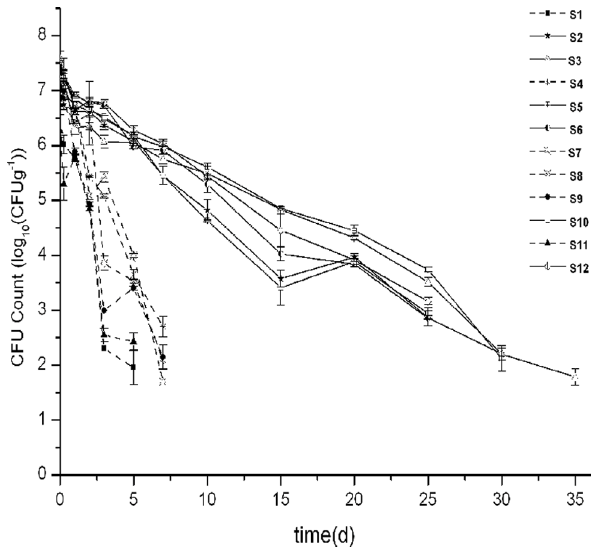
# Survival time to reach detection limit ( t d ); time needed for first decimal reduction in E . coli O157:H7 population ( d ); shape parameter ( p ). *Significant differences (p , 0.05) indicated by different letters.